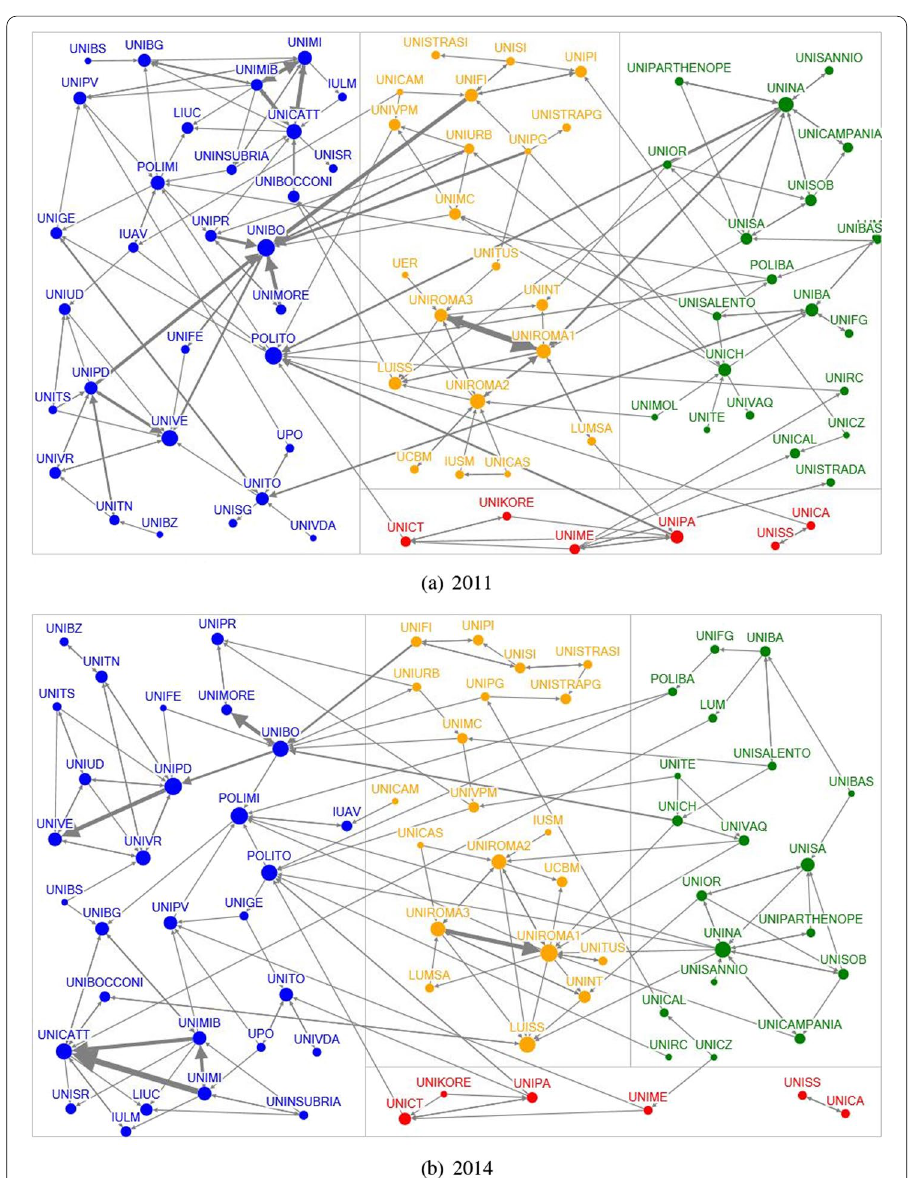
Fig. 1 Network visualisation at university level for 2011–12 and 2014–15 student cohorts. Node’s colour are related to geographical macro-areas: blue size represent the university in-degree centrality index and link’s weight is proportional to the number